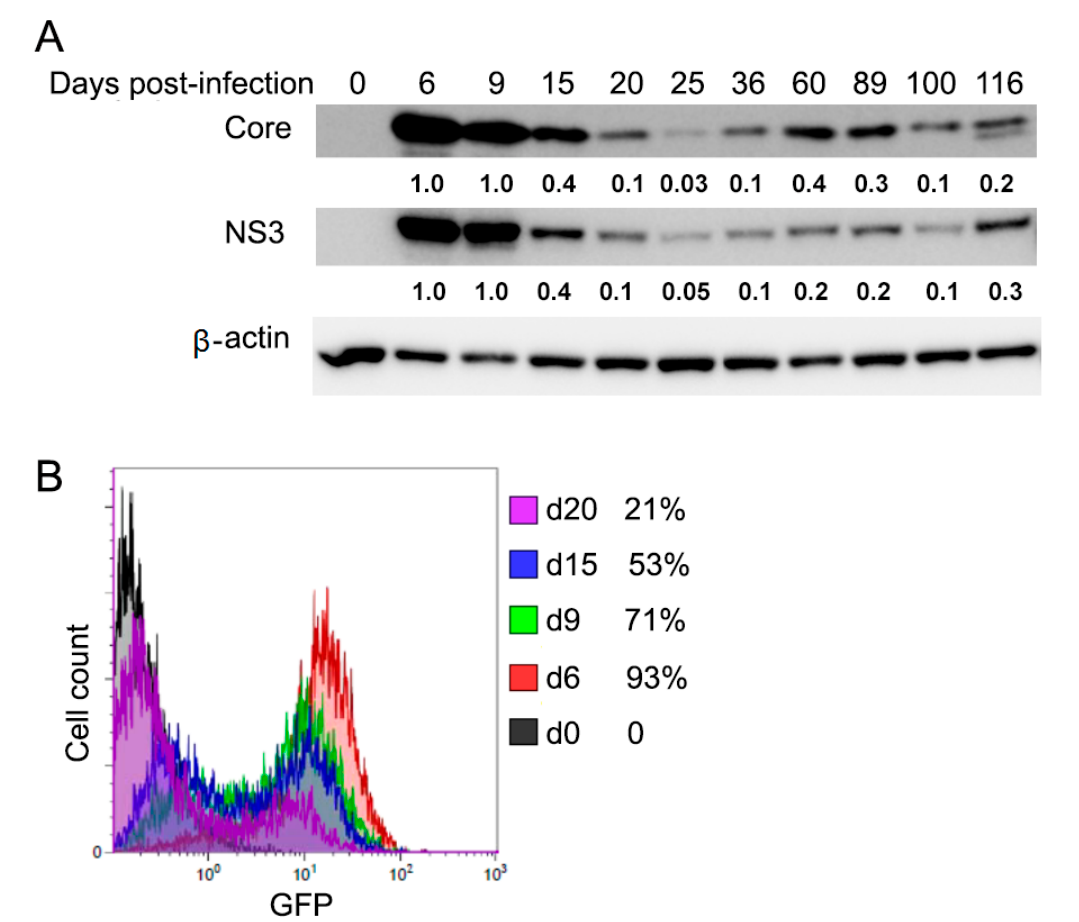
Figure 1. Dynamic expression of hepatitis C virus (HCV) proteins in acute and chronic infection in Huh7.5 cells. ( A ) Cell lysates were taken at the indicated time points (d0, d6, d9, d15, d20, d25, d36, d60, d89, d100, d116) after HCV infection and analyzed for HCV protein Core and NS3 by Western blotting. Quantification of the protein expression levels relative to the β -actin control was expressed as a ratio of the protein expression levels in the cells on day 6 (acute phase) as indicated under each lane. ( B ) Flow cytometry analysis was used to examine GFP-positive populations from HCV-infected cells at the indicated time points.